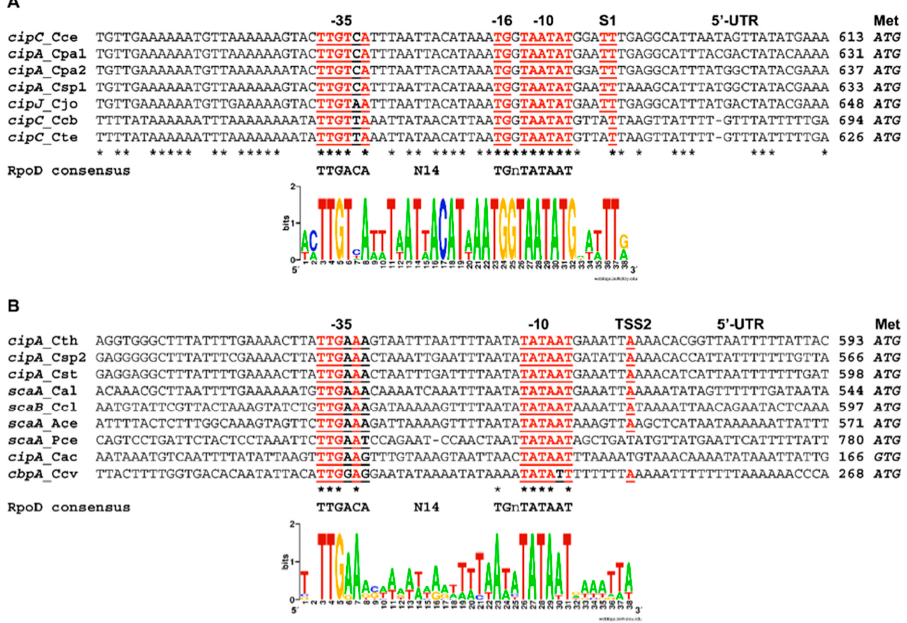
Figure 3. Sequence conservation of the major σ A -dependent promoters upstream of the respective cip gene cluster. ( A ) The σ A (RpoD)-dependent promoter and cognate transcription start site (S1) have been experimentally identified as a major region of the C. cellulolyticum H10 cipC gene [52] and its orthologs [54]. The two T nucleotides of S1 are underlined, as well as sequences predicted to be − 35, − 16 and − 10 elements of the cipC promoter; ( B ) aligned sequences are related to the recently identified RpoD-dependent promoter of the C. thermocellum cipA gene [54]. TSS2 is a transcriptional start site position, while − 35 and − 10 elements are elements of the cipA promoter. In both panels ( A and B ), 5 ′ UTR (untranslated regions) are shown partially, and numbers between the last nucleotide of each sequence and the predicted initial codon for methionine (Met) are provided. The two WebLogos were generated, with the sequences shown in each alignment, and they suggest putative promoter consensuses in the two groups of cellulolytic species. The promoter has two patterns of conservation, one in the related mesophiles, and a second in thermophiles and other complex cellulosomes (denoted † in designated species as follows). Cce, C. cellulolyticum ; Cpa1, C. papyrosolvens DSM 2782; Cpa2, C. papyrosolvens C7; Csp, Clostridium sp. strain BNL1100; Cjo, C. josui ; Ccb, C. cellobioparum ; Cte, C. termitidis ; Cth † , C. thermocellum DSM 1313; Cst † , C. straminisolvens JCM 21531; Ccl, C. clariflavum DSM 19,732; Ace † , Acetivibrio cellulolyticus CD2; Ccv, C. cellulovorans ; Cac, C. acetobutylicum ; Pce † , Pseudobacteroides ( Bacteroides ) cellulosolvens ATCC 35603 (DSM 2933). Asterisks (*) indicate sequenced positions with identical